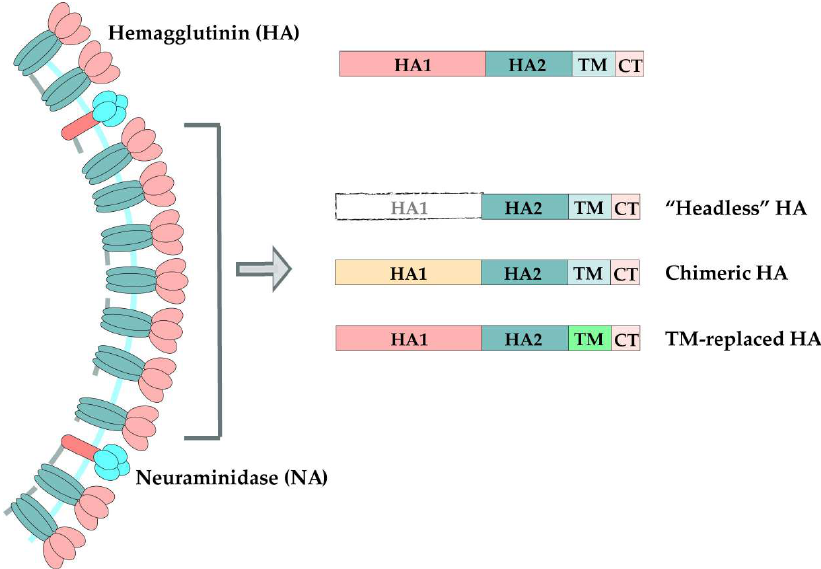
Figure 2. The schematic diagram of various strategies in the universal influenza vaccine